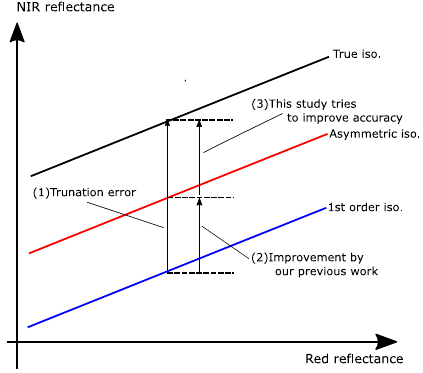
Figure 3. Illustration of the truncation error in the vegetation isoline equations and its improvement by this and previous